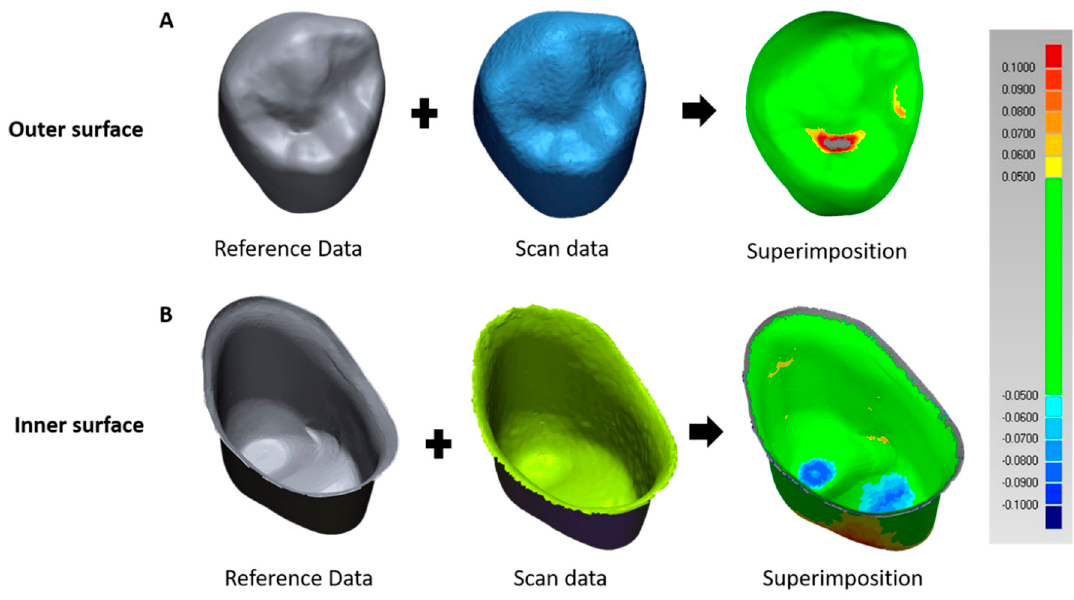
Figure 2. Milling accuracy evaluation method using a three-dimensional program. ( A ) Superimposing of outer surface reference data and scan data using a three-dimensional program. ( B ) Superimposing of inner surface reference data and scan data using a three-dimensional program.